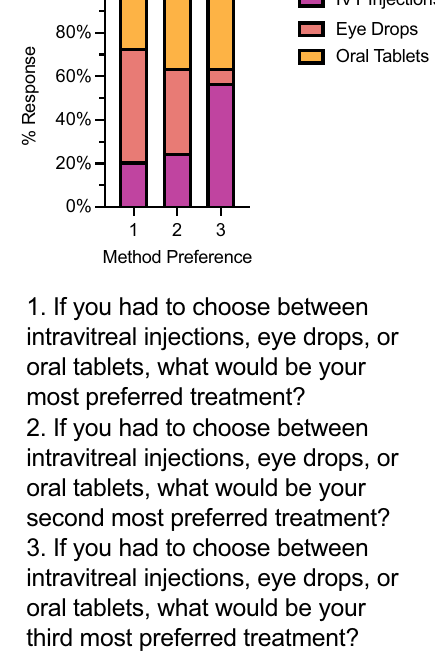
Figure 4. ( a ) Opinions on alternative treatment delivery routes to IVT injections expressed as a 100% stacked column chart of Likert-scaled responses from survey questions. n = 51–52 responses as in Table 2. ( b ) Frequency of preferred treatment delivery method by rank (1 = most preferred; 3 = least preferred). 1st choice n = 52; 2nd choice n = 44; 3rd choice n =